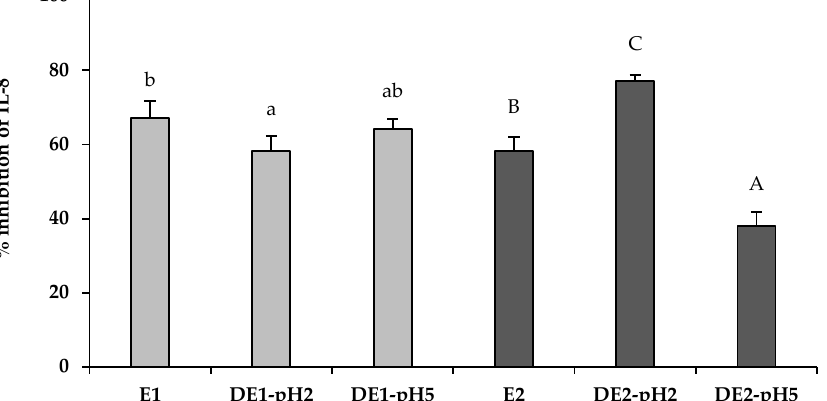
Figure 2. Inhibition effect of olive leaf extracts (E1 and E2) and their gastric digests at pH 2 and pH 5 (2 mg/mL) on pro-inflammatory cytokine IL-8 production by human gastric epithelial AGS cells after H. pylori infection. The experimental control (AGS cell without extracts) had 0% of IL-8 inhibition (data not showed). Values are the mean ± SD (n = 3). a,b, ab, A,B,C Different letters indicate statistical difference within a same extract by ANOVA post hoc HSD Tukey test ( p < 0.05).